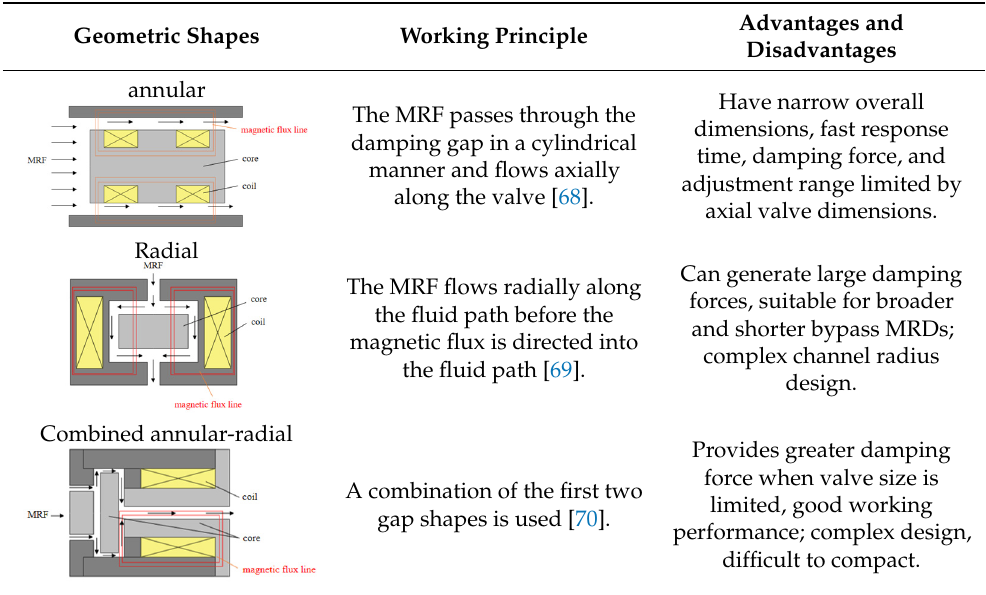
Table 2. The geometric arrangement of the working channel.